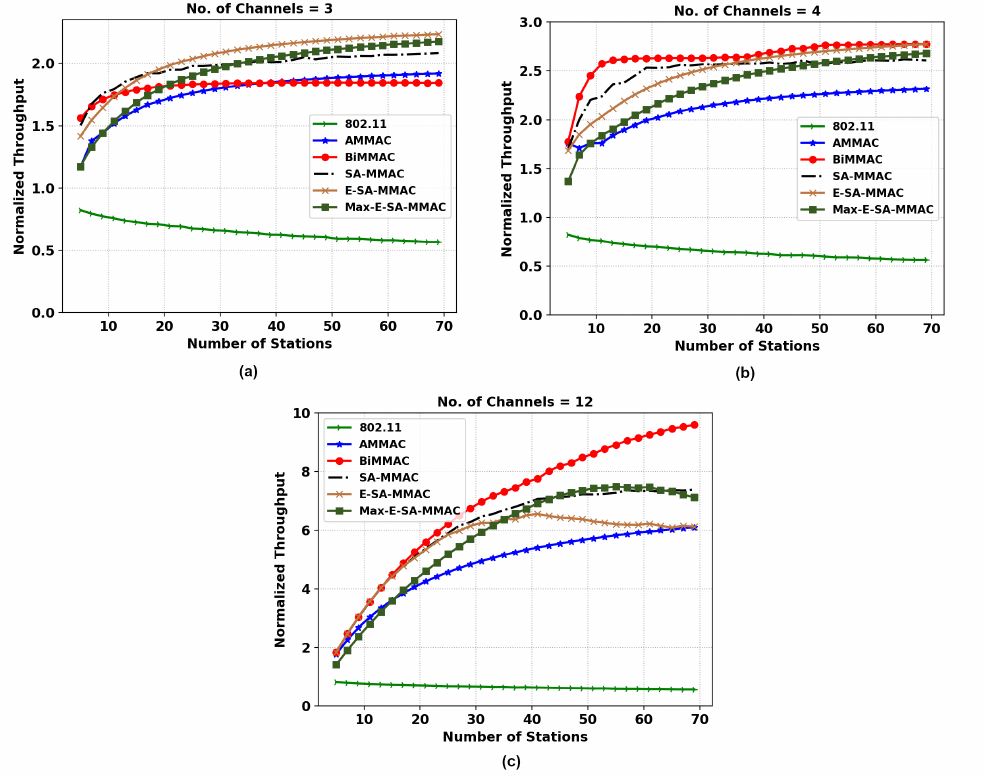
Figure 6. Normalized throughput comparison of the two MMAC protocols, E-SA-MMAC and Max-E-SA-MMAC, versus others; ( a ) 3, ( b ) 4, and ( c ) 12